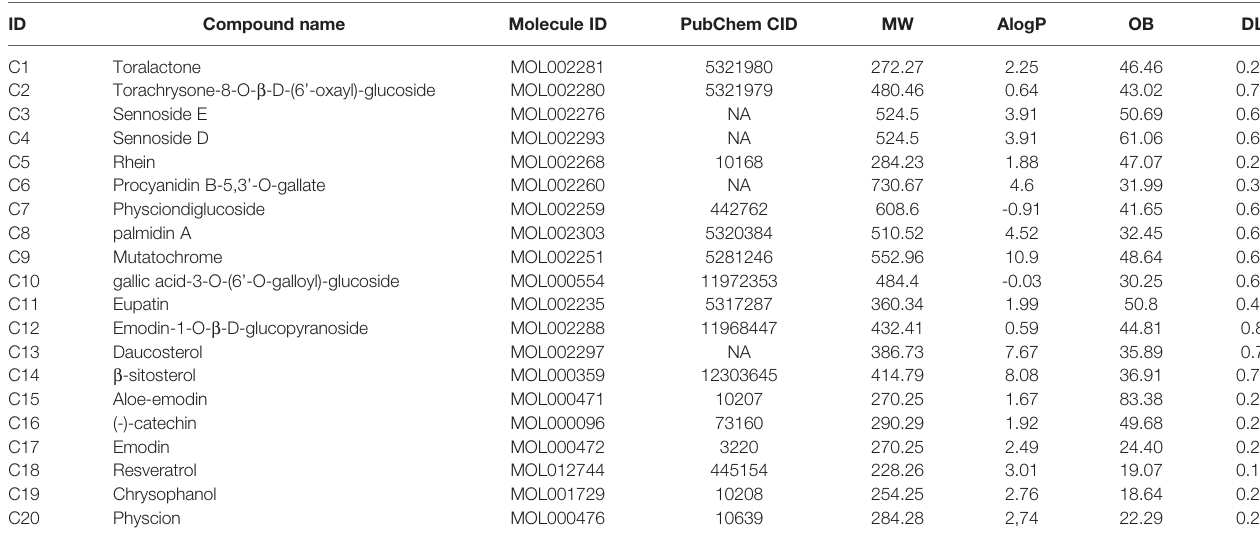
TABLE 1 | The main molecular descriptors for the potential active